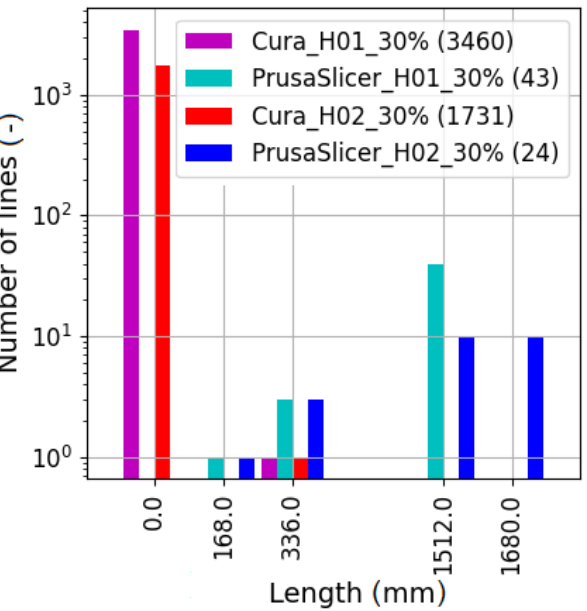
Figure 6. Total length of the lines for continuous